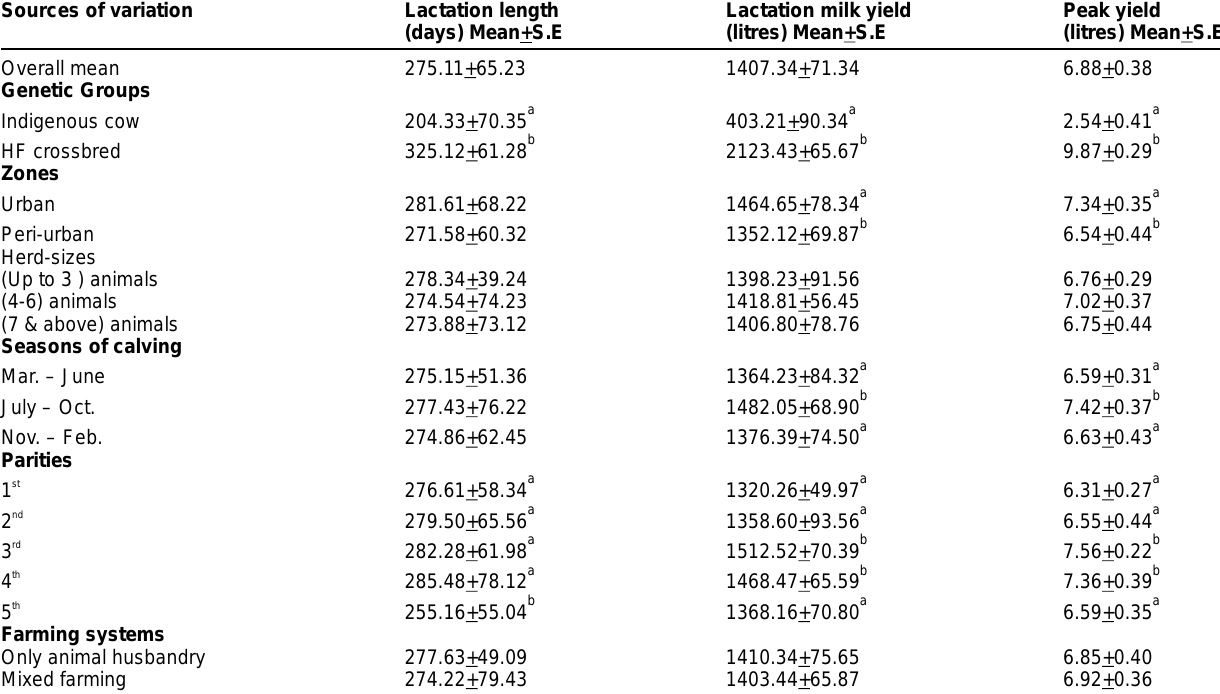
Values superscripted by similar letter were not significantly different from each